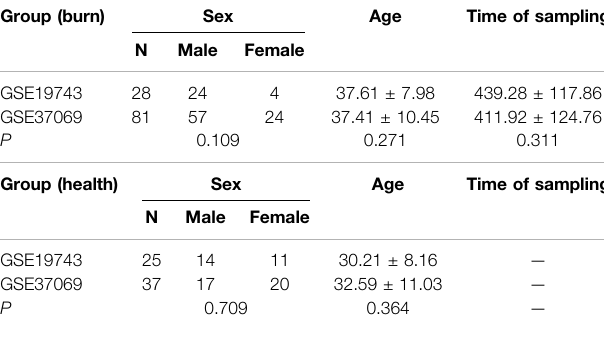
TABLE 1 | Clinical data of burn patients and health controls in GSE37069 and